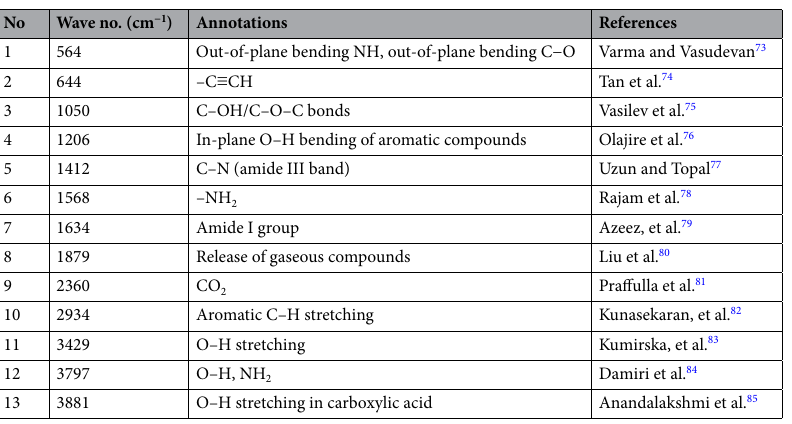
Table 4. FTIR peaks of biosynthesized chitosan nanoparticles with the annotations and references of each